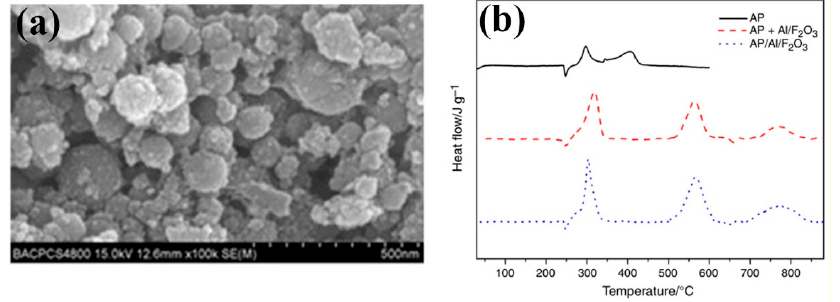
Figure 33. Temporal pressure rise curves during the reaction of (Al/Fe 2 O 3 /NC) p composites pre- pared by simple physical mixing and Al/Fe 2 O 3 /RDX/NC composites containing different RDX contents prepared by electrospray process. Reproduced with the permission of ref. [151]. Copyright 2019, Journal of Thermal Analysis and Calorimetry.